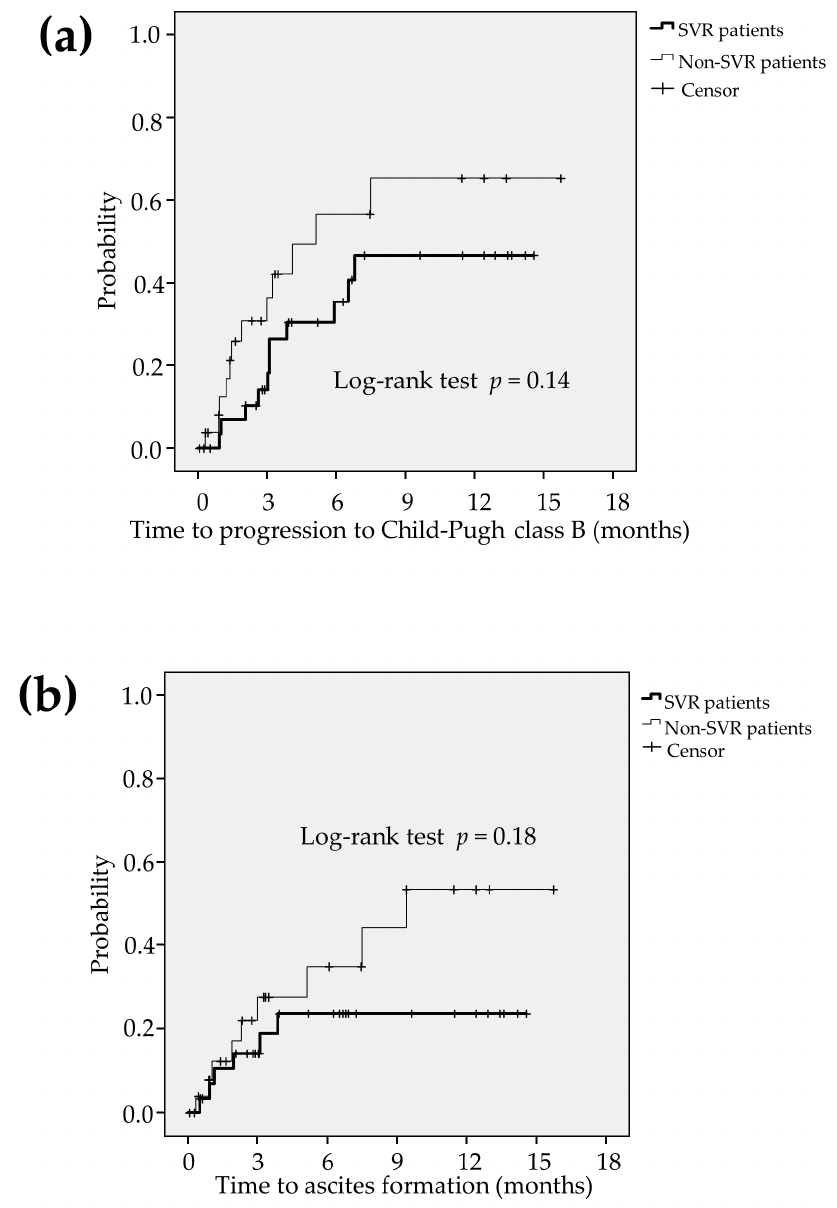
Figure 5. Among HCC patients infected with HCV ( n = 58), HCV eradication was achieved in 32 patients (55.2%) (defined as SVR patients) and HCV-persistent infection was found in 26 patients (44.8%) (defined as non-SVR patients). During the lenvatinib treatment, there were not significant differences in time to progression to CP-B ( p = 0.14; ( a )) and formation of ascites ( p = 0.18; ( b )) between the SVR patients and non-SVR patients. CP-B: Child-Pugh class B, HCC: hepatocellular carcinoma, HCV: hepatitis C virus, SVR: sustained virological response.